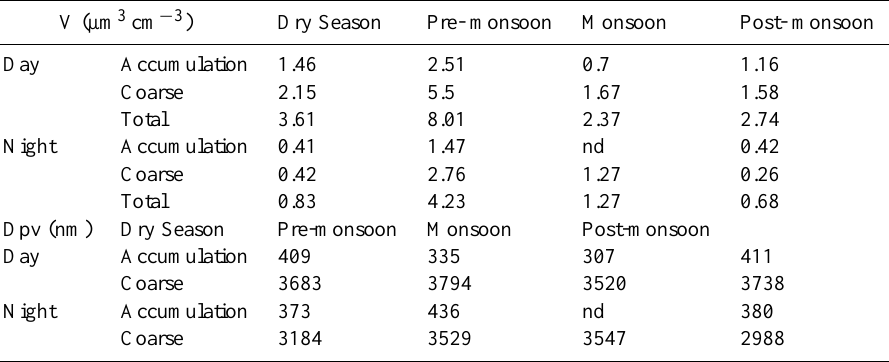
Table 2. Daytime and nighttime median integrated volume concentrations in the accumulation and coarse modes and total volume concen- tration during different seasons. Geometric Mean volume diameter of the accumulation and coarse modes during different